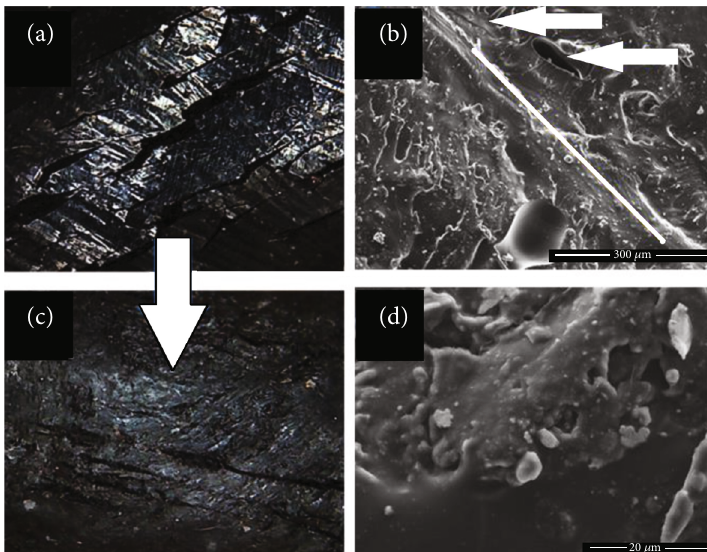
Figure 11: SEM images of nanocomposite surfaces before (a, b) and after (c, d) self-healing; self-healed surface sites are marked with a white line and arrows.